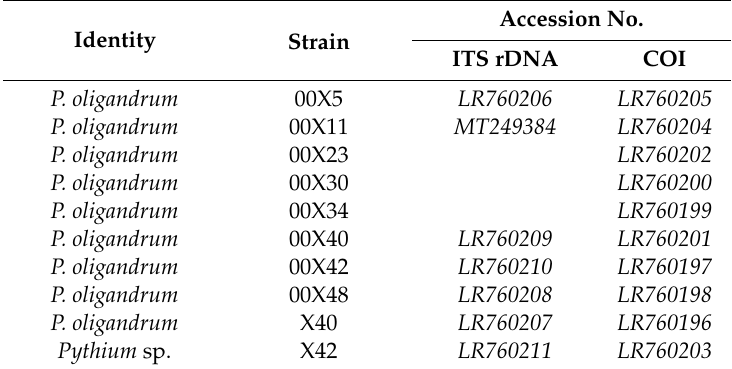
Table 1. Summary of Pythium spp. and their identification parameters (internal transcribed spacer (ITS) rDNA and cytochrome c oxidase subunit I